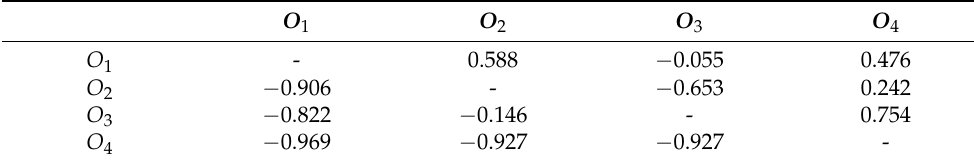
Table 21. The total dominance matrix.